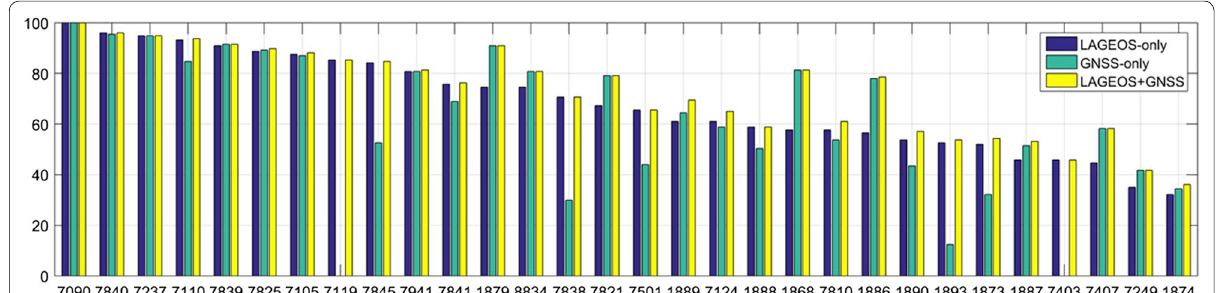
Fig. 4 The occurrence of SLR stations in 7-day solutions in the period 2014.0–2017.5 expressed in % (percentage of possible to obtain 7-day station positions)